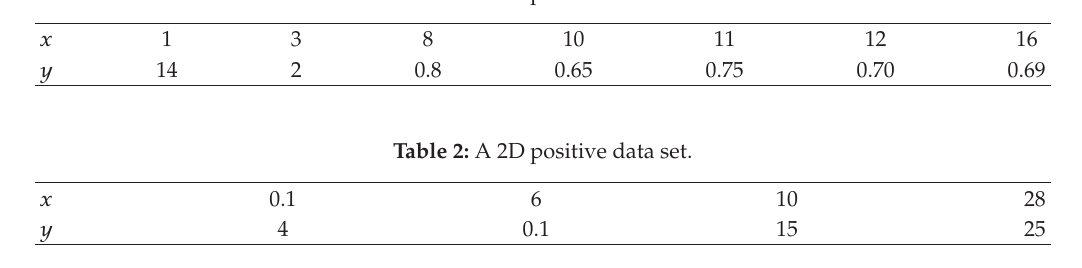
Table 1: A 2D positive data set.